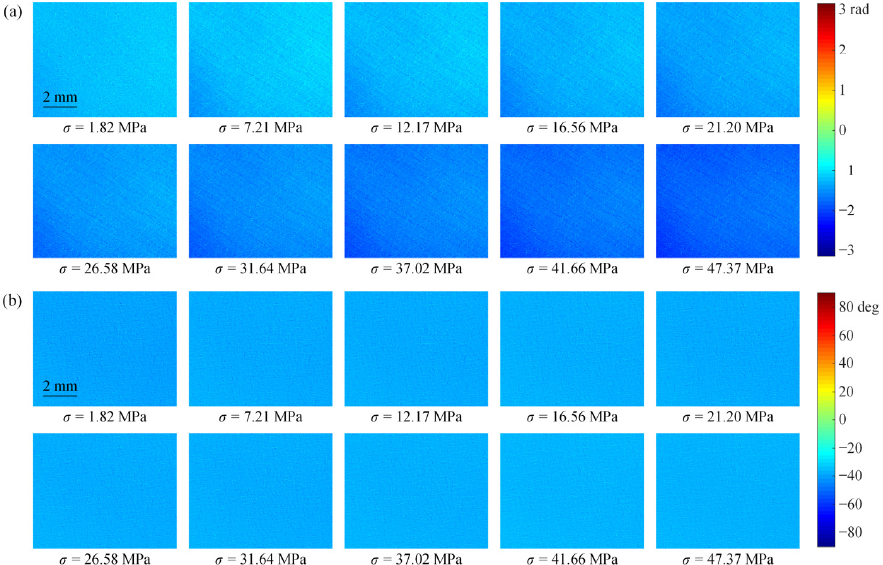
Figure 3. The full-field ( a ) isochromatic phase and ( b ) isoclinic angle distribution of the PET specimen with ϕ = − 15 ◦ obtained in the transmission photoelastic experiment.